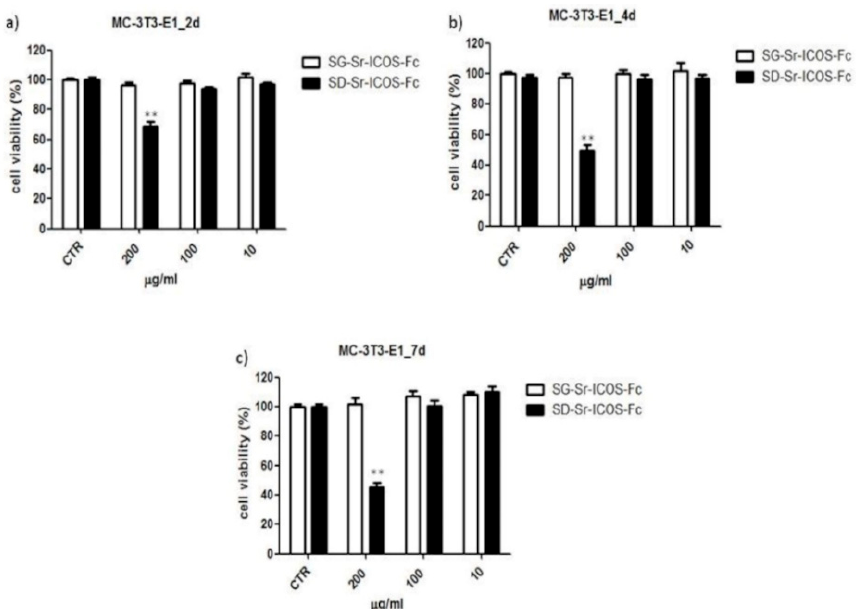
Figure 12. Cell viability studies performed on SG-Sr-ICOS-Fc (white bars) and SD-Sr-ICOS-Fc (black bars) samples with MC3T3-E1 cell line at different exposure times ( a ) 2 d, ( b ) 4 d, and ( c ) 7 d considering different particle concentrations. ** p < 0.01 vs. untreated cells (CTR) (Dunnett’ s test). The graphs show cell viability (%) as mean and standard error obtained from three independent experiments. Cell viability was calculated with the following formula: cell viability = absorbance of sample/absorbance of control (untreated cells) ×